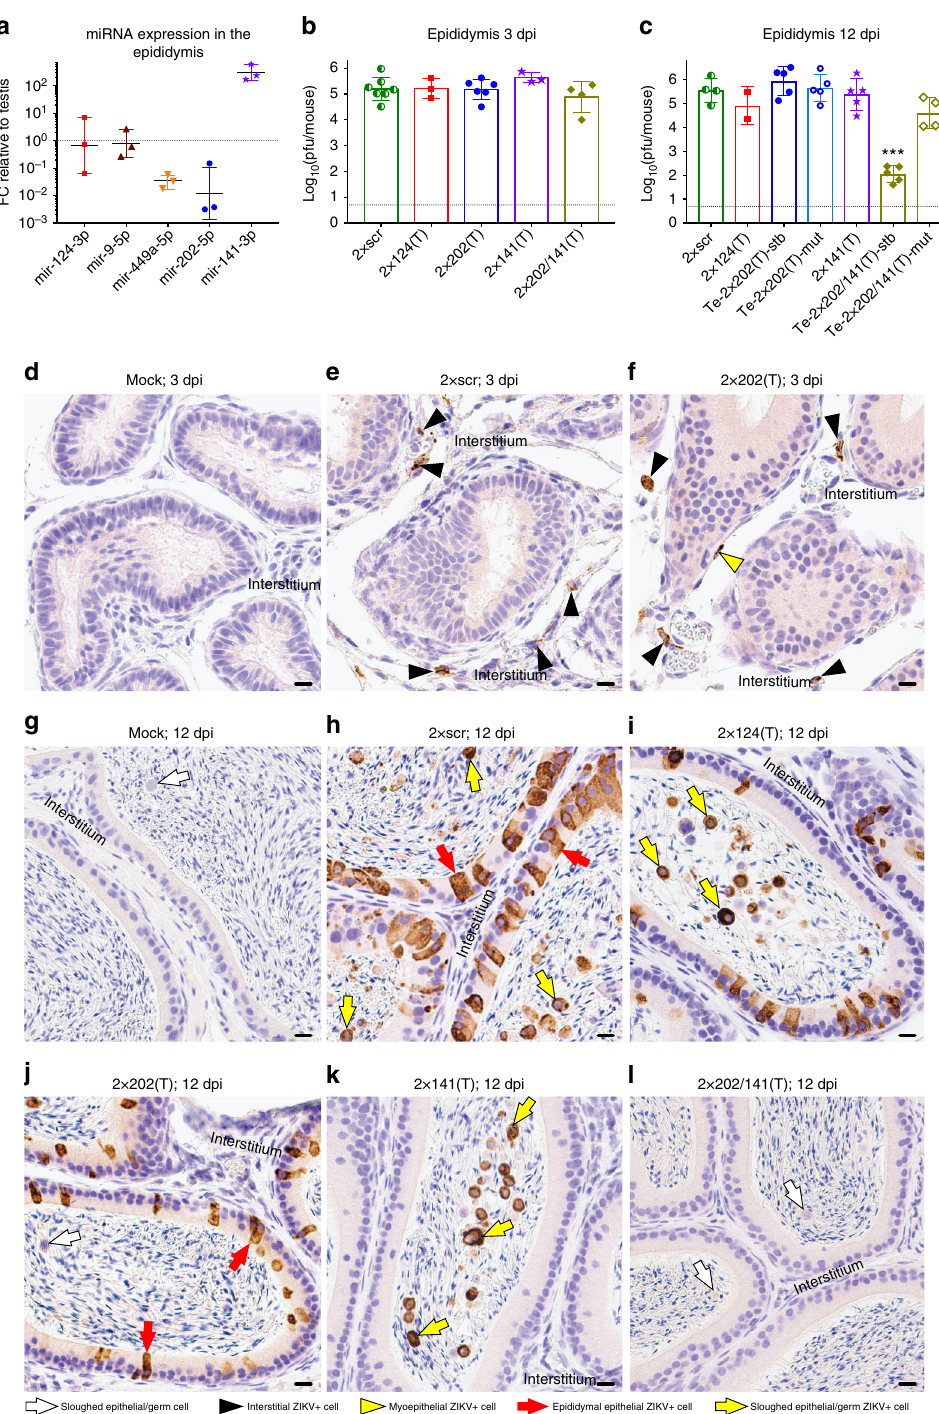
Fig. 4 Replication of the miRNA-targeted ZIKVs in the epididymis of AG129 mice. a Relative expression of selected miRNAs in the mouse epididymis compared with their expression in the testis. Data show the ratio (FC) of normalized counts for miRNAs isolated from the epididymis to those isolated from the testis of AG129 mice ( n = 3). Horizontal lines and error bars are geometric means and geometric SDs, respectively. b – k AG129 mice were infected ip with 10 6 pfu of 2×scr or miRNA-targeted viruses and were killed at 3 or 12 dpi. b and c Mean viral titers ± SD (shown as error bars) in the epididymis of mice at 3 dpi b and 12 dpi c . Epididymides dissected from mice infected with 2×202(T) or 2×202/141(T) at 12 dpi were divided into two groups based on the miRNA target sequence stability (see Fig. 2 for details). The dashed line indicates the limit of virus detection (0.7 log 10 (pfu/epididymis)). Differences between the titers of 2×scr and each of miRNA-targeted viruses in the epididymis were compared using one-way ANOVA (*** p < 0.001). d – l Representative images of ZIKV antigen distribution in the epididymides of mice that were mock-inoculated or infected with indicated viruses are shown on the indicated dpi (2 – 6 mice per group). The epididymal interstitium is indicated. Labeling used within panels is indicated at the bottom of the fi gure. Scale bars: 10 µ